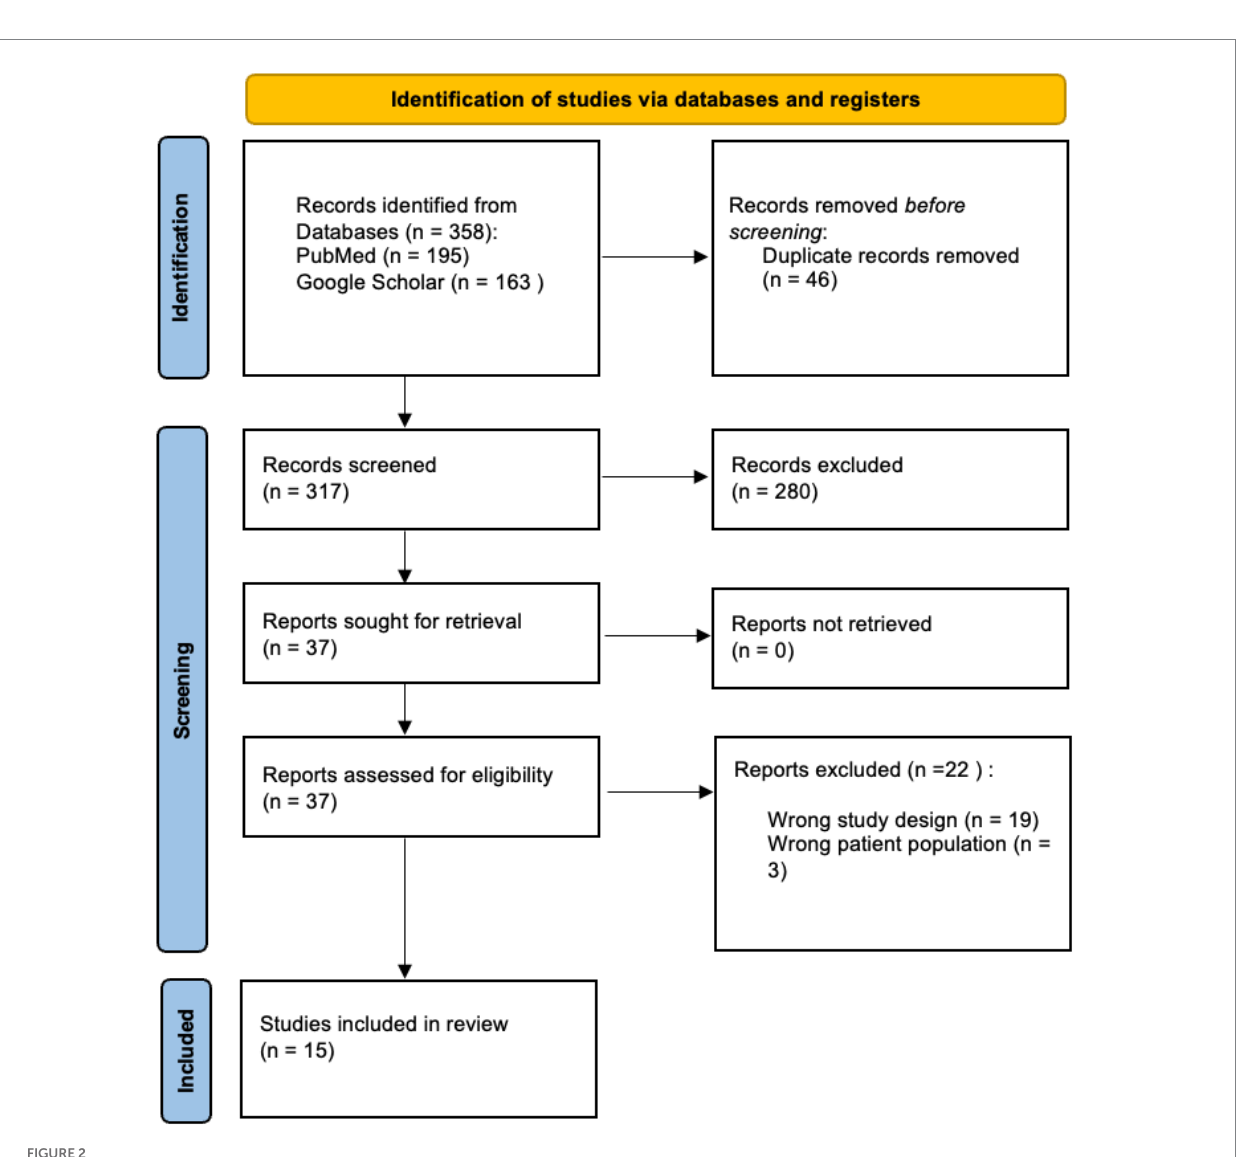
FIGURE 2 PRISMA 2020 flow diagram for systematic reviews which included searches of